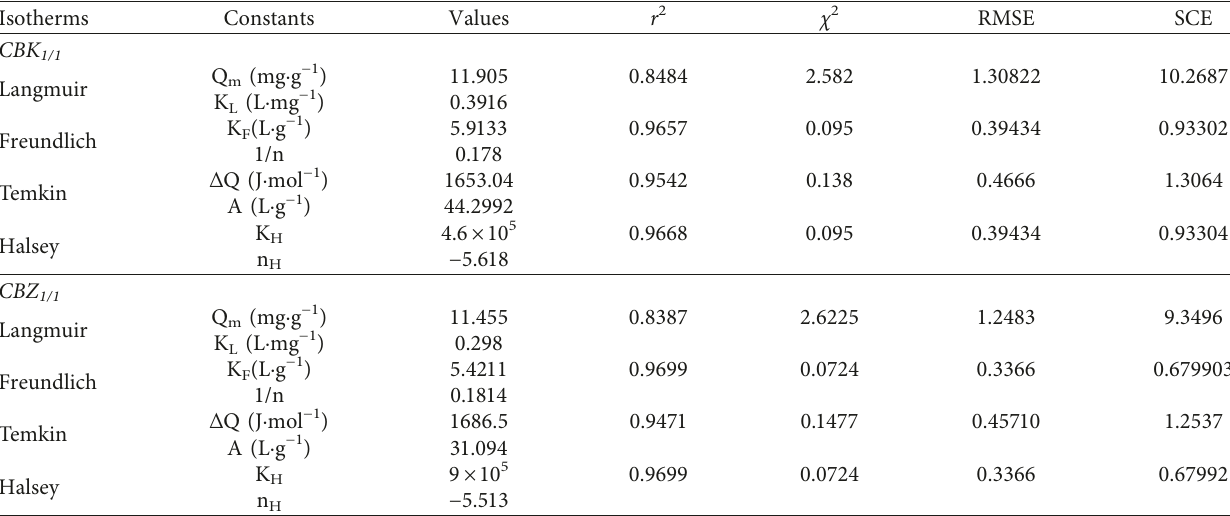
Table 6: Linear parameters of isotherm models for adsorption of IC onto